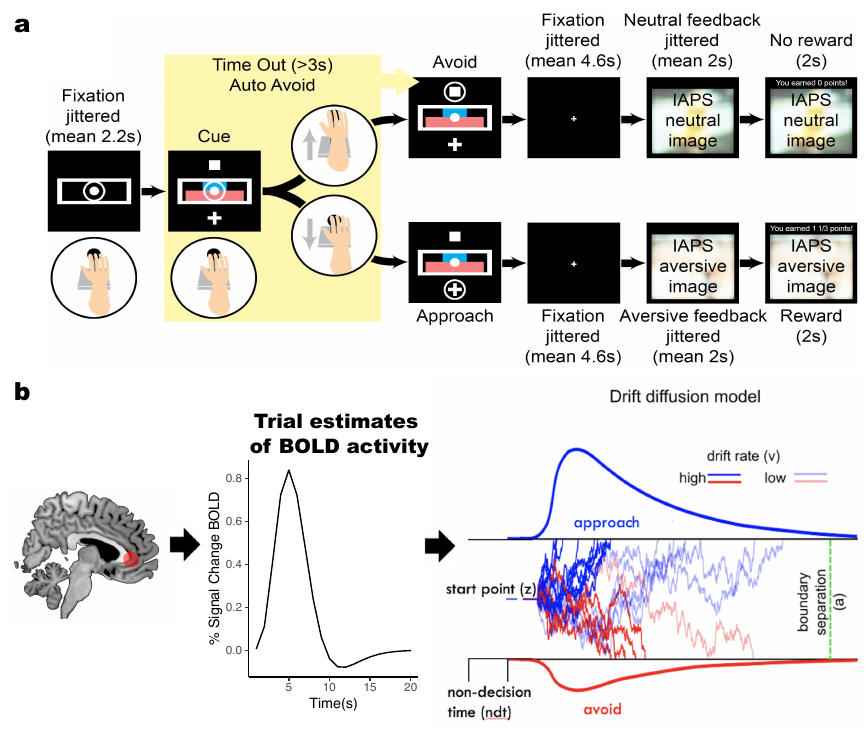
Fig 1. Experimental task and computational model. a , Participants used a joystick to decide whether to approach or avoid a combined offer of reward (points) and aversiveness (aversive stimuli). The magnitude of offered reward and aversiveness were represented by the width of the blue and red bar, respectively. b , Illustration of drift diffusion model applied to approach-avoidance conflict task. Trial-by-trial BOLD activity from regions of interest were used as regressors to measure their impact on decision parameters in the DDM. The DDM adapted to the approach-avoidance conflict task was used to estimate how trial-by-trial changes in offered reward and aversiveness (as well as neural correlates) altered the speed and sign of evidence accumulation (controlled by the drift rate (v)) to decide to approach (upper bound) or avoid (lower bound) offers. The boundary separation (a) parameter measures the distance between decision thresholds, the starting point bias (z) measures a priori tendencies to approach or avoid offers, while the non- decision time (ndt) parameter captures time spent on stimulus encoding and motor response. The illustration of the DDM is adapted from